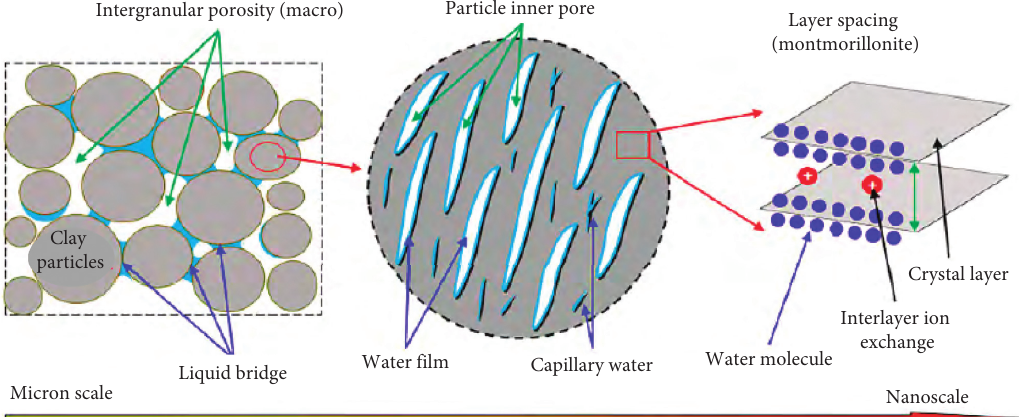
Figure 5: Characteristics of gas water distribution of clay minerals [21].